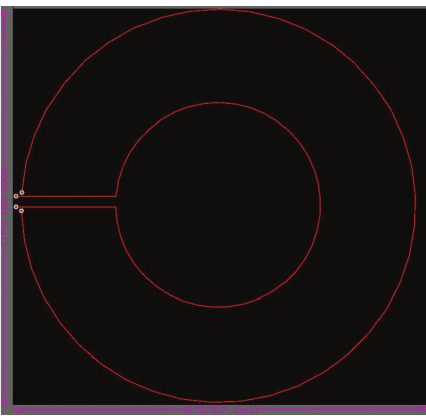
Figure 5: The PCB layout design of STC antenna.